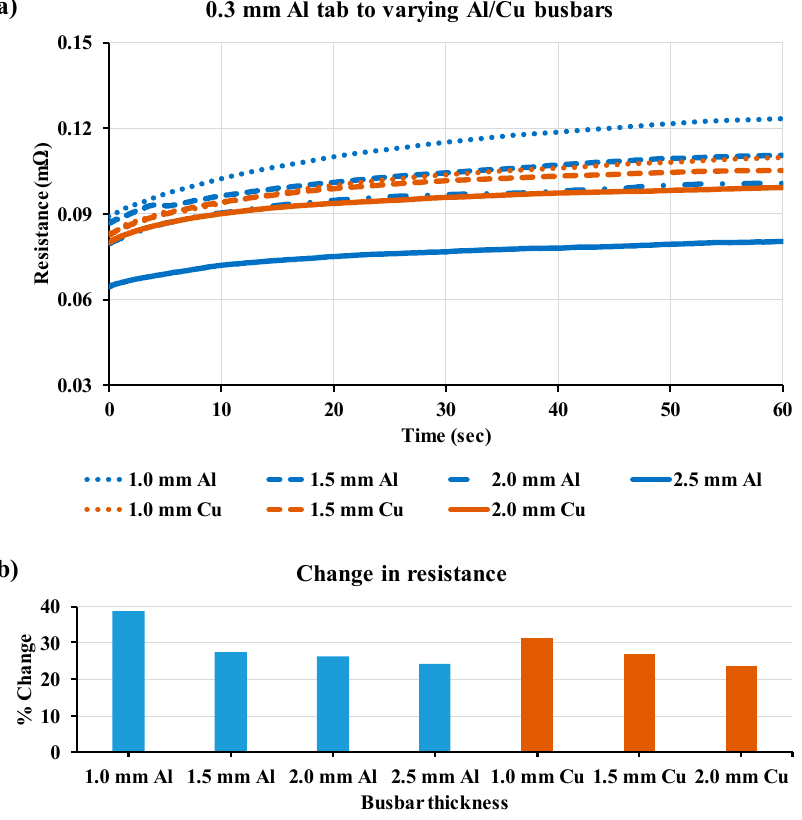
Figure 4. ( a ) Electrical resistance profiles for 0.3 mm Al tab to Al / Cu busbars; and ( b ) the percentage (%) changes in resistance.